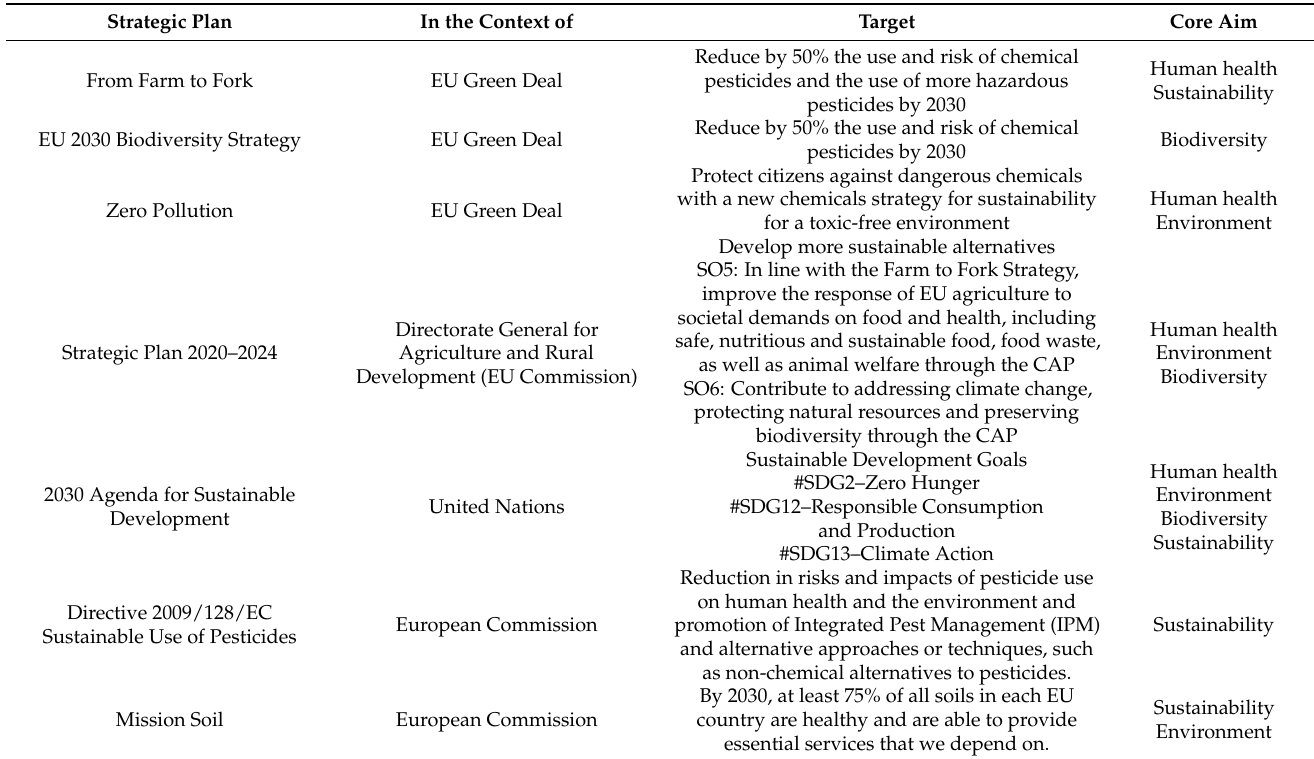
Table 1. The most important strategies/directives for chemical pesticide reduction both in the European Union and